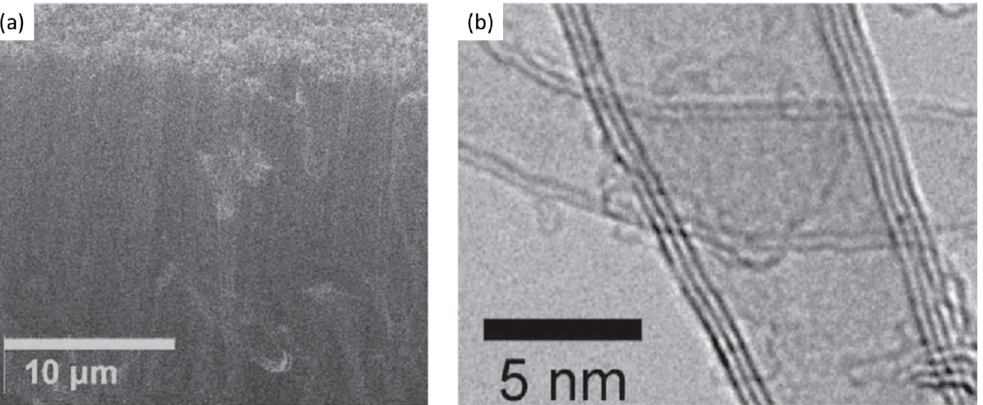
Figure 14. ( a ) SEM micrograph of VACNT grown on 100 nm TiN DBL at a substrate temperature of 400 °C; ( b ) TEM image of CNT taken from the identical sample. Modified after [87]. Vollebregt et al. (2014) [71] used TiN DBL with Al/Co top-layer as a DBL top-cover and catalyst layer. The Co catalyst was beneficially used to grow VACNT at tempera- tures as low as 350 °C due to the need for much lower activation energy than for the Fe catalyst (details given in Table 5). Favorable, the presence of Al further enhanced the Co nanoparticle stability that resulted in VACNT. For example, the top layer of 3 nm alloy